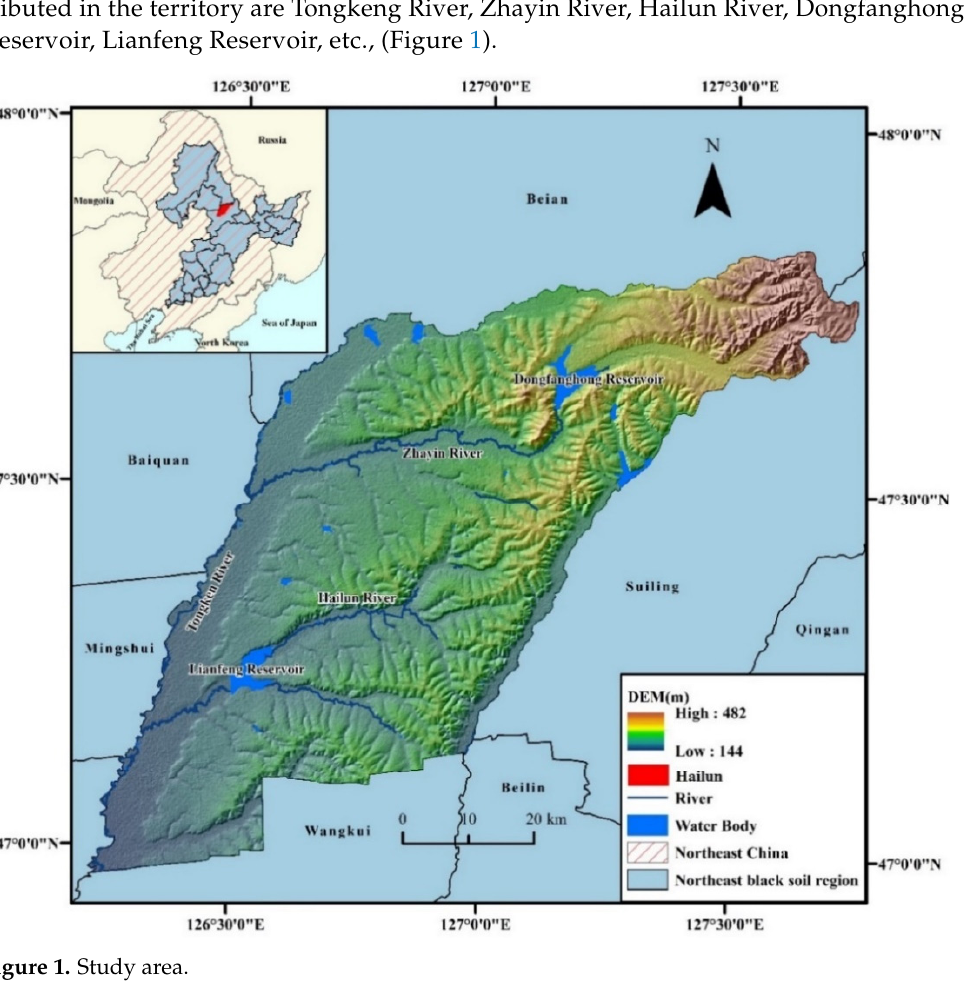
Figure 1. Study area.